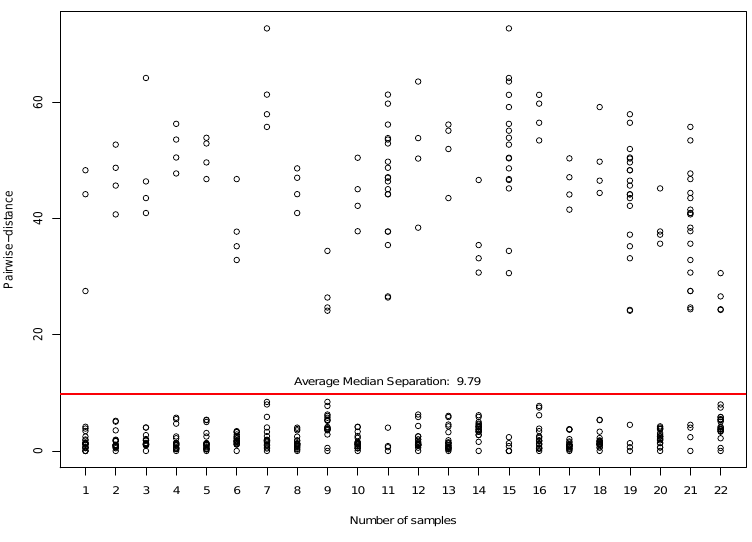
Figure 9. Pairwise-distances for temperature sensors in a range of 100 km from the coordinates of London, UK, in Dataset 1, considering only sensors with correlation r ≥ 0 . 8